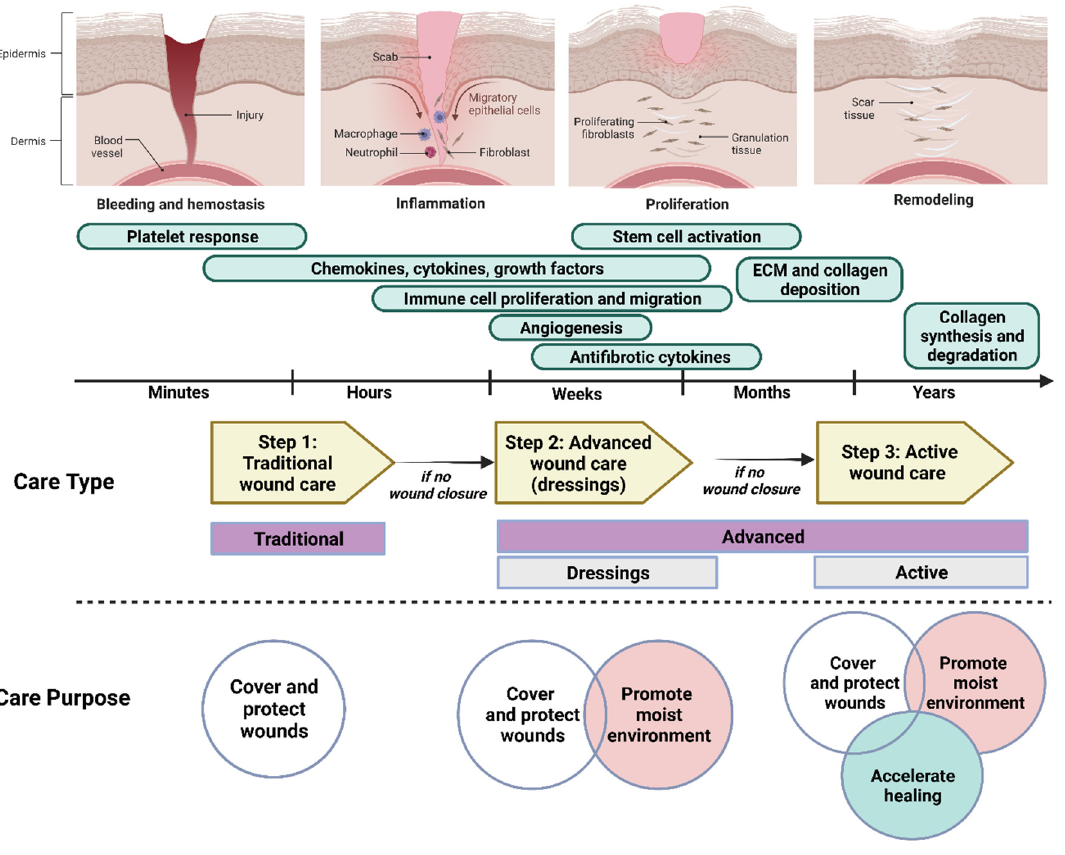
Figure 1. Four different phases of wound healing that are involved different cellular events and mechanisms, as well as the type and purpose of wound care used at different time points after injury. Created with BioRender.com (accessed on 26 July